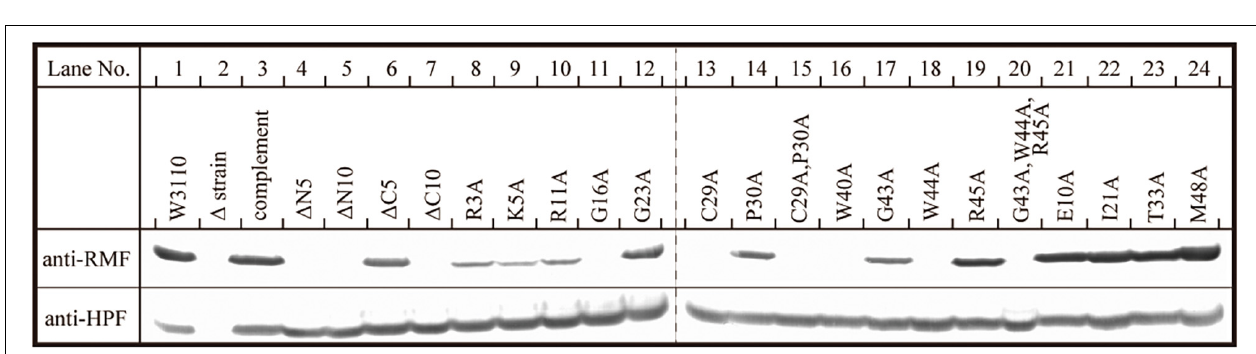
FIGURE 5 | Binding of mutant RMF and intact HPF to ribosomes, analyzed by western blotting. RMF and HPF in ribosomal fractions (see arrows in Figures 2–4 ) were detected by using the appropriate rabbit antisera. These experiments were repeated as shown in Supplementary Figures 3, 4, and the effects of RMF mutations on dimer formation and ribosome binding are evaluated from these data as shown in Table 2